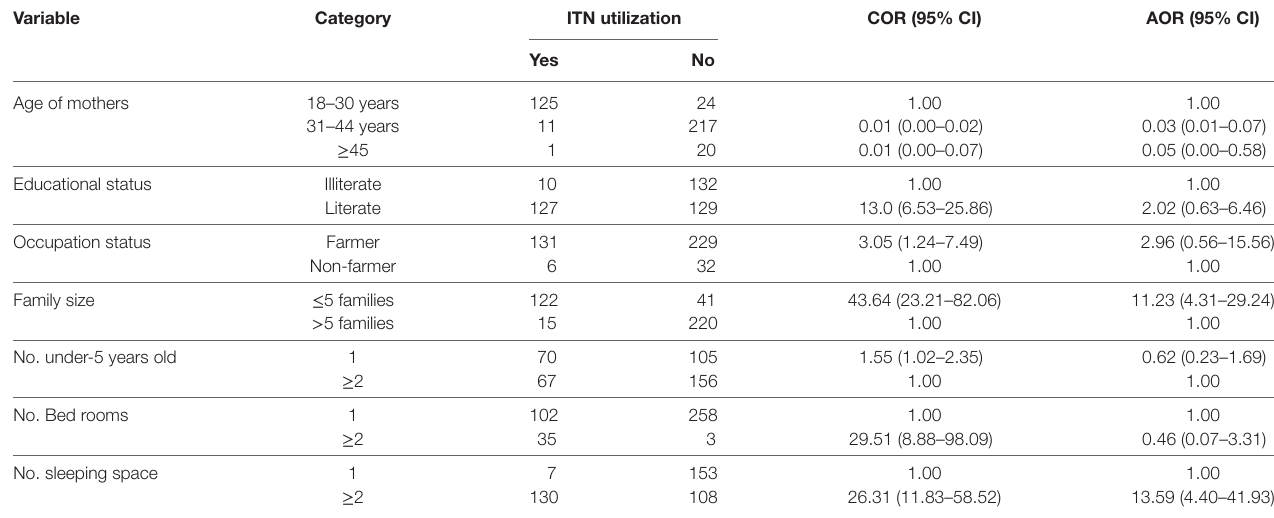
TaBle 3 | Factors associated with insecticide-treated mosquito net (ITN) utilization among under-5 years old children of Mirab Abaya District, Gamo Gofa Zone, August to September, 2016. Variable